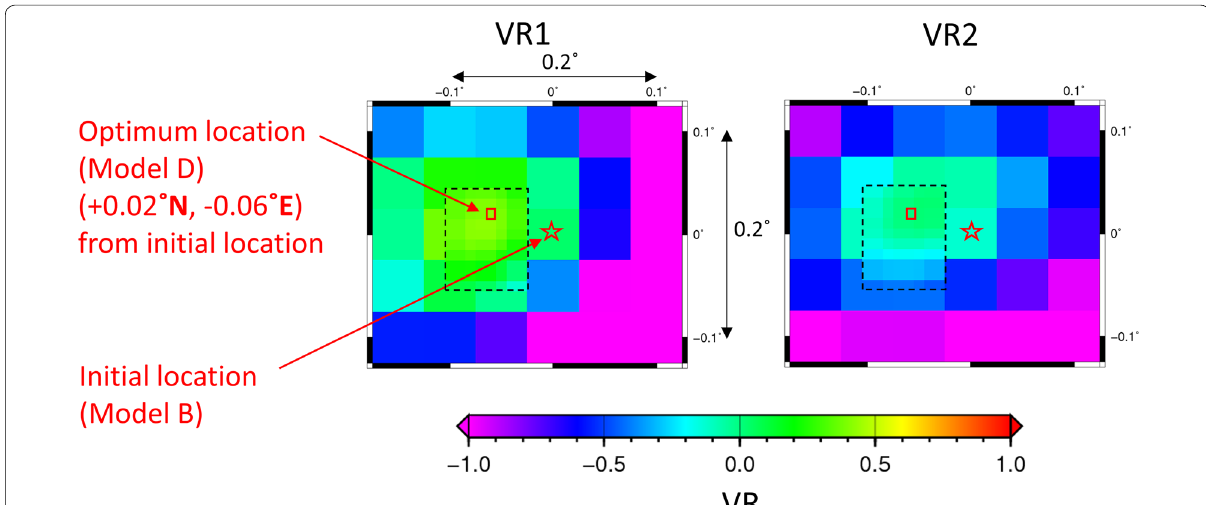
Fig. 8 Spatial distribution of mean values of VR for model D, the horizontally shifted version of model B. The color scale indicates the values of VR, and the spatial scale indicates the difference from the initial position. The initial shift from the location of model B (red star) was 0.05°; then the dashed rectangle was searched at increments of 0.01° to find the optimal location (red square)